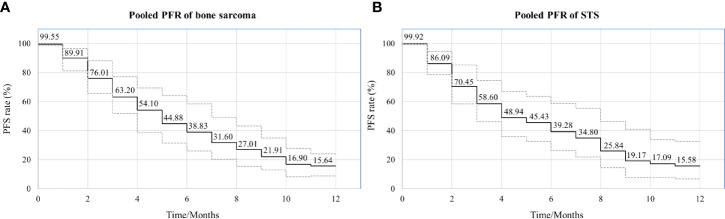
Pooled estimates of PFS between the two subgroups. (A) PFS curve in bone sarcoma; (B) PFS curve in STS.